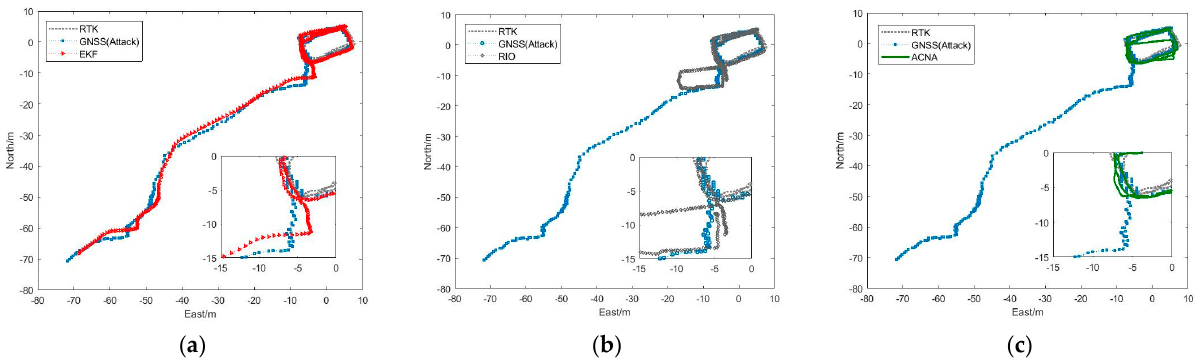
Figure 15. The position error of the three algorithms on data set